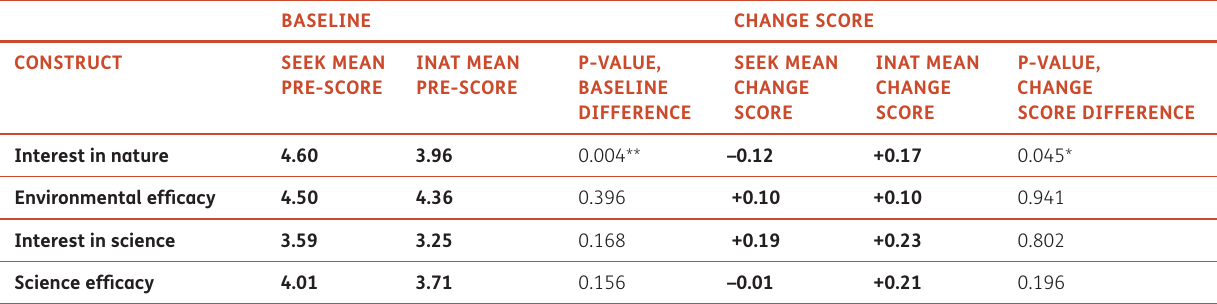
Table 2 Baseline and change score comparison between 2020 assignment choices (Seek versus iNaturalist). Note : Comparison of students’ baseline (pre) mean scores and post-citizen science assignment change scores (post minus pre) for Seek (n = 36) and iNaturalist (iNat) (n = 29) assignments in 2020 for all four constructs of interest. All items rated on a scale from 1 (Strongly Disagree) to 5 (Strongly Agree). For baseline and change score differences, p-values represent results of Welch’s two-sample t-tests comparing baseline scores or change